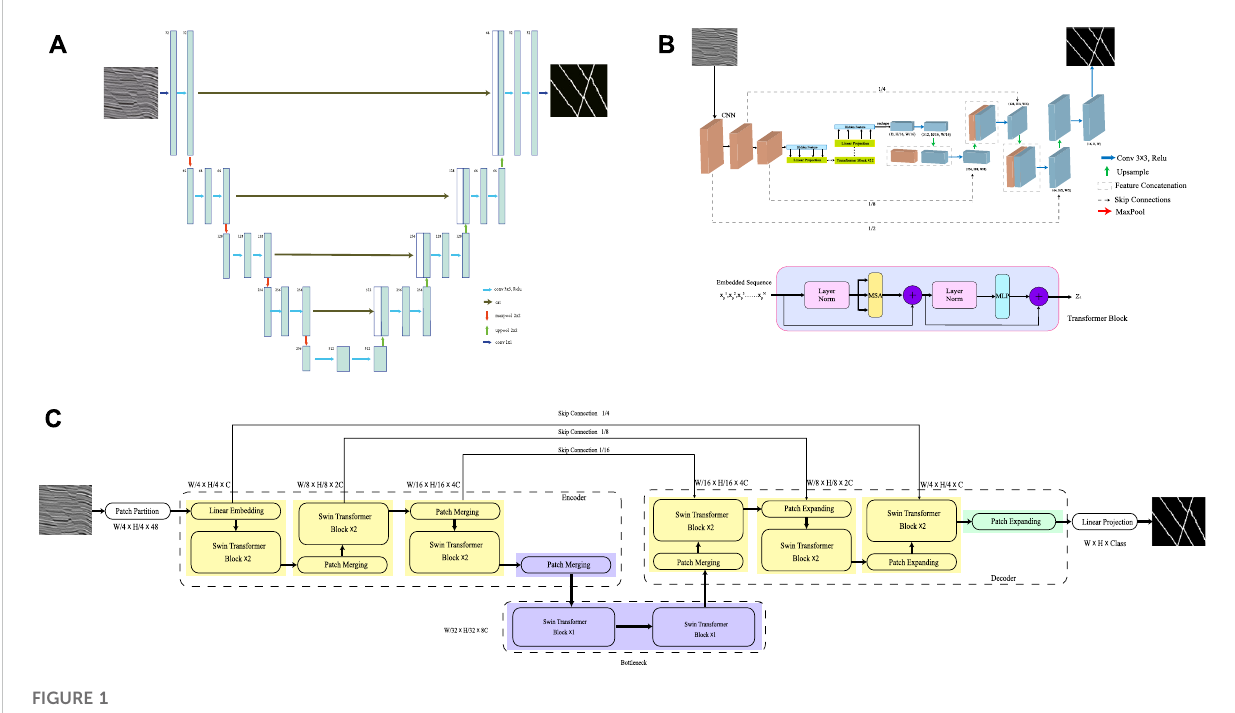
Architectures of (A) classical Unet, (B) TransUnet, (C)